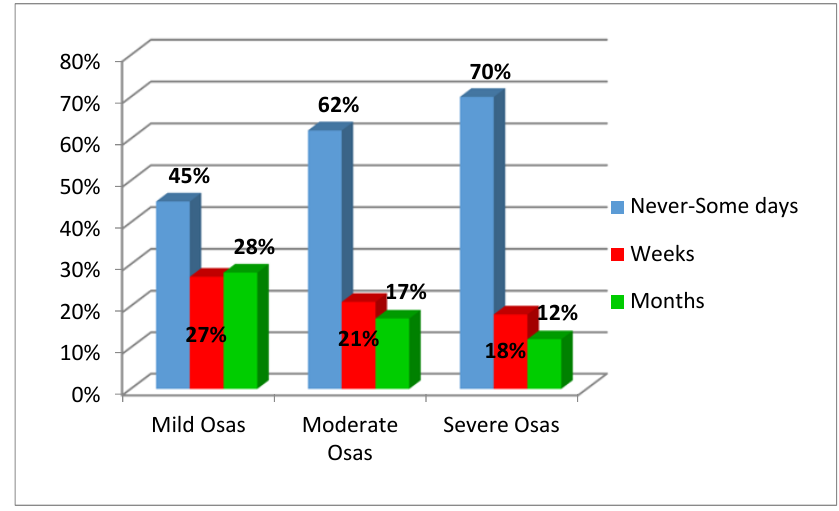
Figure 2. Relation between obstructive sleep apnea syndrome severity and swallowing problems.